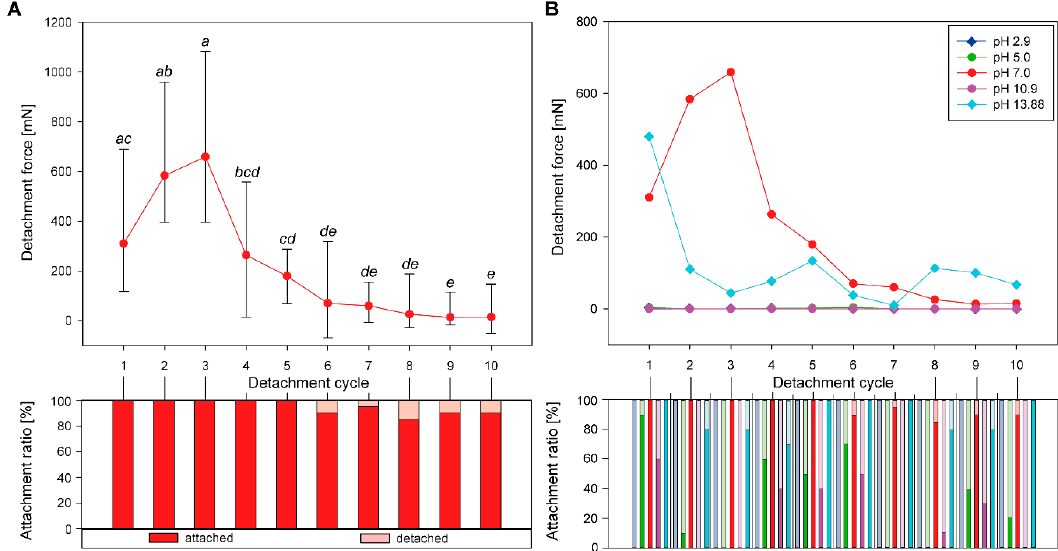
Figure 2. Sequential detachment force measurements of P. philippinicum eggs: ( A ) Line plot (above) and the corresponding count of attached and detached eggs (attachment ratio, below) for sequential measurements of eggs exposed to pH 7.0. Error bars indicate s.d., dots represent the median. Groups with the same letter are statistically not different (Friedman repeated measurement ANOVA on ranks, Tukey’s post hoc test, p < 0.05); ( B ) Line plots (above) and the corresponding attachment ratio (below) for sequential measurements of eggs exposed to different pH values (line plots for pH 2.9 and 5.0 largely overlap with pH 10.9, see Figure 4A for details).